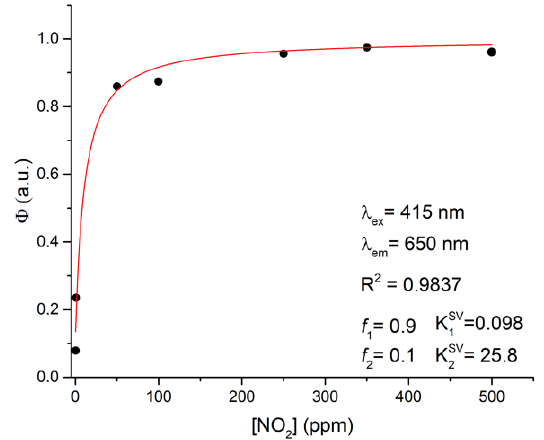
Figure 7. Quenching values Φ of the TCPC@MOF@PDMS film emission vs. NO 2 concentration and their fitting to the two-site Stern-Volmer model (see text for details).